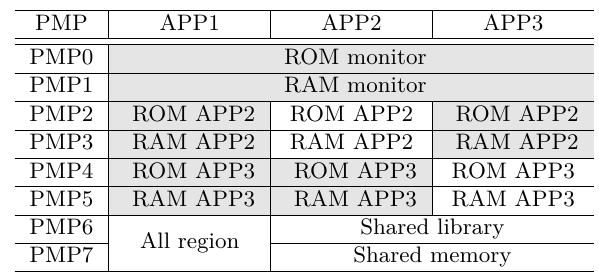
Table 2: PMP usage for switching method. The gray and white cells represent configu- rations with no accessibility (R=0, W=0, X=0) and all accessibility (R=1, W=1, X=1), respectively. In the case of ”all region,” PMP6 and PMP7 construct one entry with TOR. Apart from that, all PMP entries use